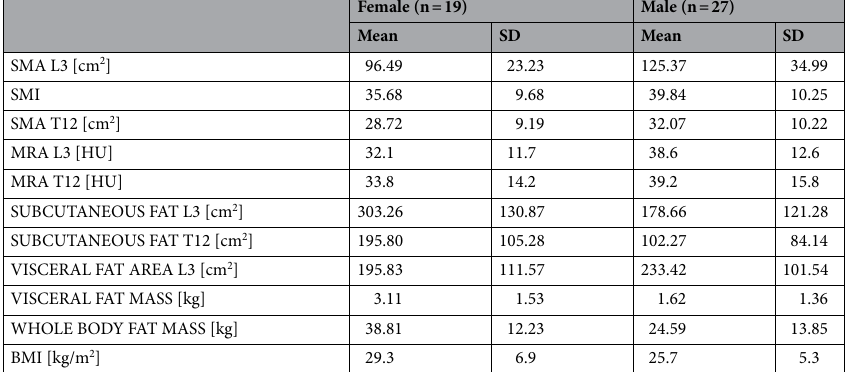
(47.8%) patients were dependent on intermittent or continuous dialysis and 13 (28.3%) patients received extra- corporeal membrane oxygenation (ECMO) therapy. Distribution of CT body composition parameters and sarcopenia. Sex-specific mean values and SD of all CT parameters, the SMI, BMI, visceral and body fat mass are provided in Table 1. In men, MRA values at T12 and L3 were slightly higher (T12: 39.2 HU; L3: 33.8 HU), which indicated less fat accumulation within the muscle fibers, than in women (38.6 HU; 32.1 HU). However, compared to the sex-, age-, and BMI-specific percentiles of van der Werf et al. for the MRA at L3, more men were below the 5th per- centile (n = 26, 56.5%) and thus considered to have low muscle quality, than women (n = 17, 37.0%). Like the BMI, the subcutaneous fat area, the visceral fat mass, and whole-body fat mass were smaller in male patients (Table 1). The SMI could be determined for 20 male and 12 female patients, for whom body height was given. Judged by the sarcopenia cut-off values, men in this study collective were sarcopenic up to two times more often than women. In detail: according to the cut-off values for the SMI of Prado et al. 29 18 men and six women were sarcopenic, by the cut-off for the SMI of Martin et al. 30 17 men and seven women. 11 male patients and three female patients were below the sex-, age-, and BMI-specific 5th percentile for the SMI proposed by van der Werf et al. 28 , while five male and three female patients were below the 5th percentile for the MRA. An overview of the sex-specific distribution of sarcopenia classification results and variance of fat as well as muscle parameters at L3 is provided in Fig. 2. Relationship between CT parameters at T12 and L3.